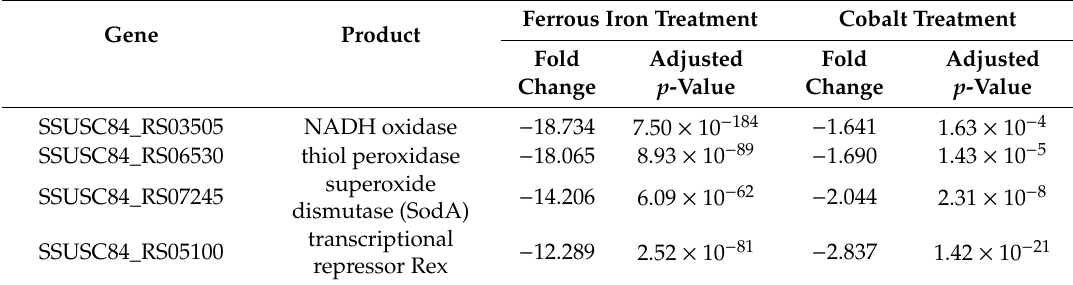
Table 3. Expression levels of genes involved in oxidative stress tolerance in the presence of ferrous iron and cobalt 1 .